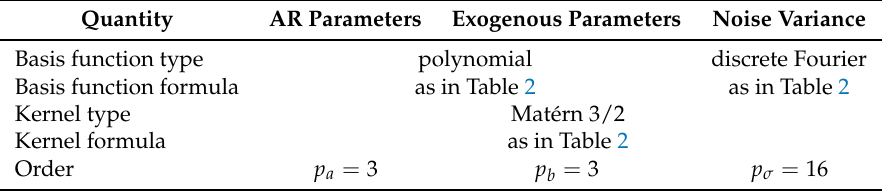
Table 5. Shear frame: GPR basis functions, kernels, and orders.